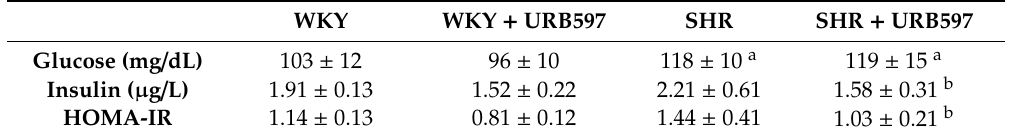
Table 1. Plasma glucose and insulin concentrations as well as the homeostasis model assessment of insulin resistance (HOMA-IR) after prolonged activation of ECS in normotensive control Wistar Kyoto rats (WKY) and spontaneously hypertensive rats (SHRs). The data are expressed as the mean ± SD, n = 6 in each group. a P < 0.05 significant di ff erence: control group (WKY) vs. examined group; b P < 0.05 significant di ff erence: SHR vs. SHR +